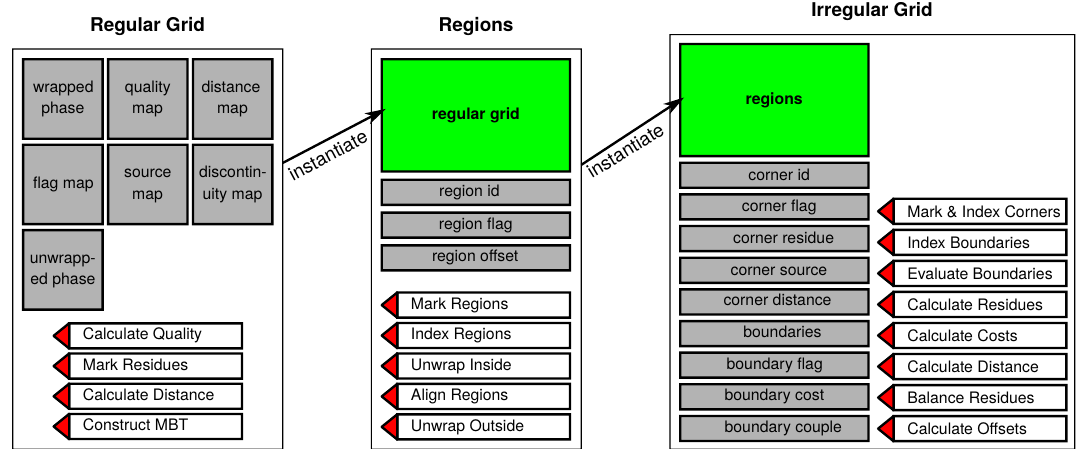
Figure 7. The main data and processing of structures Regular Grid, Regions, and Irregular Grid in the